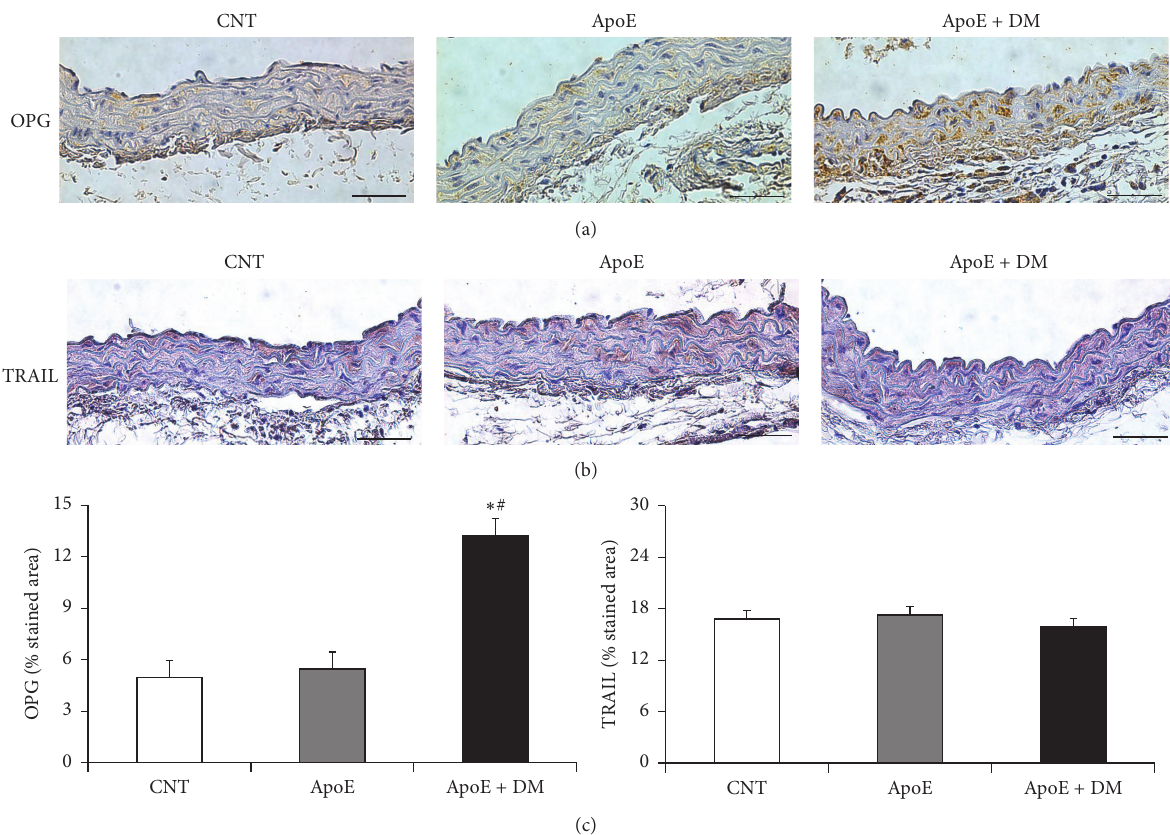
Figure 3: Effect of dyslipidemia and diabetes on aortic OPG and TRAIL protein expression. (a) Representative sections of aorta immunostained for OPG and (b) TRAIL (original magnification 25x). (c) Aortic OPG and TRAIL protein expression reported as percentage stained area. Scale bar = 50 𝜇 m. Data show mean ± SEM. ∗ 𝑝 < 0.05 versus CNT; # 𝑝 < 0.05 versus ApoE. CNT is for C57BL/6J mice; ApoE is for ApoE −/− mice; ApoE + DM is for ApoE −/− mice + diabetes